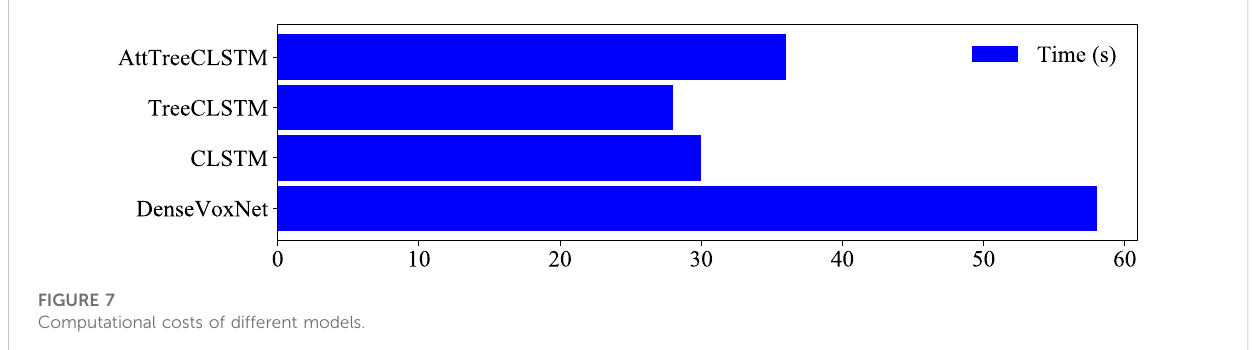
FIGURE 7 Computational costs of different